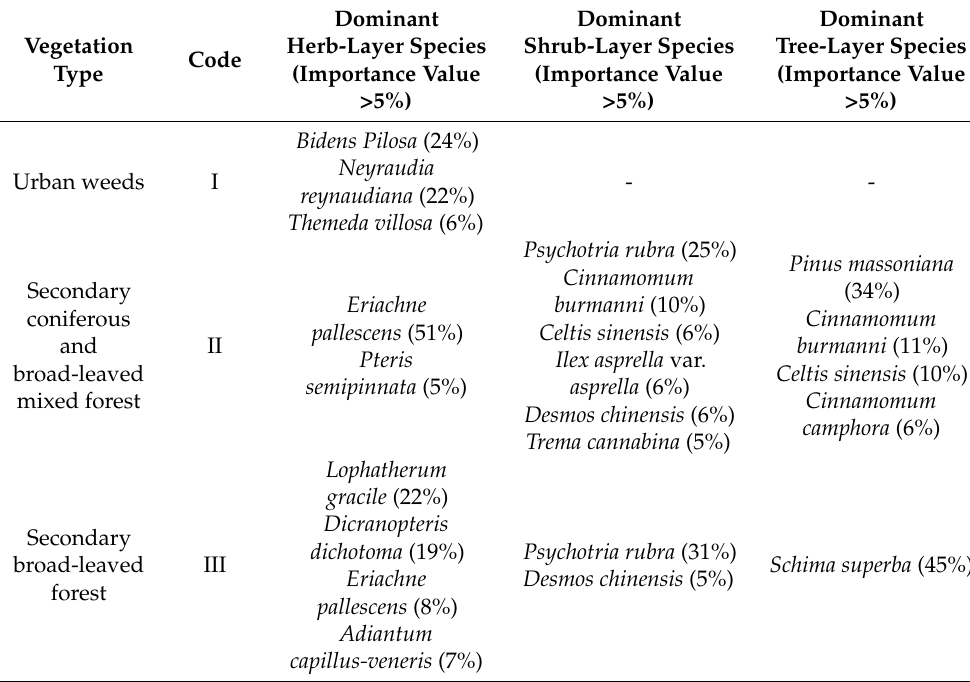
Table 4. The dominant species in three vegetation types in Guangzhou, southern China.